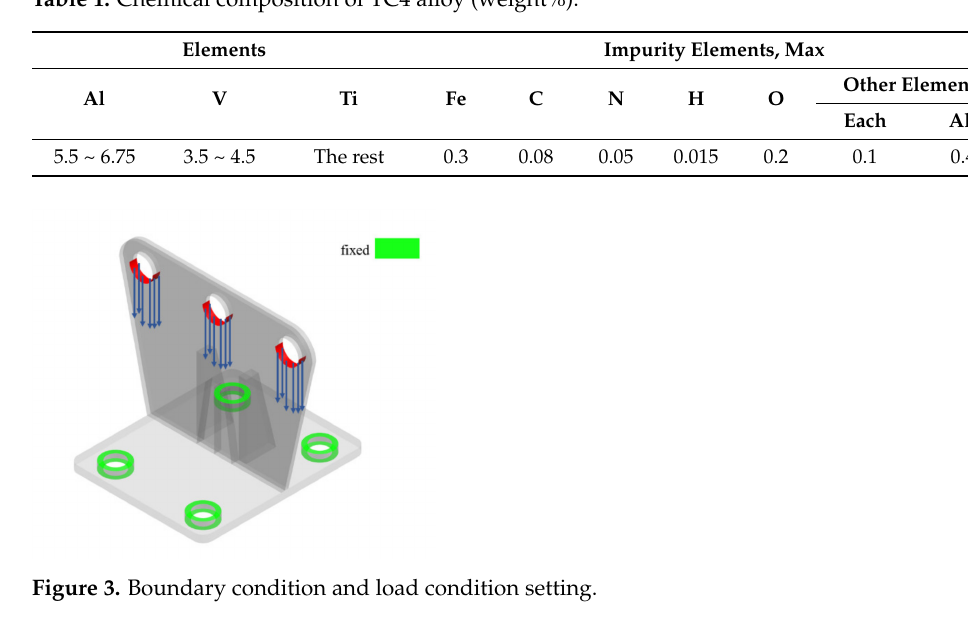
Figure 2. The schematic diagram of the assembly of the original bracket and the fatigue testing platform. Table 1. Chemical composition of TC4 alloy (weight%).